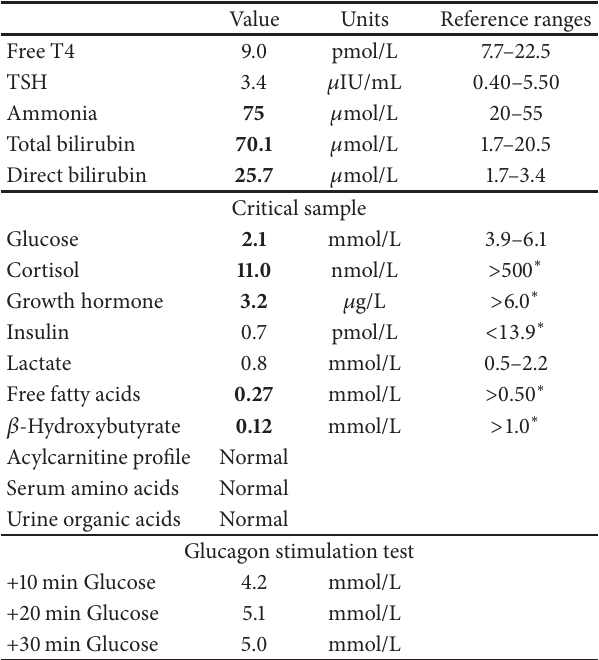
Table 1: Summary of pertinent lab values.